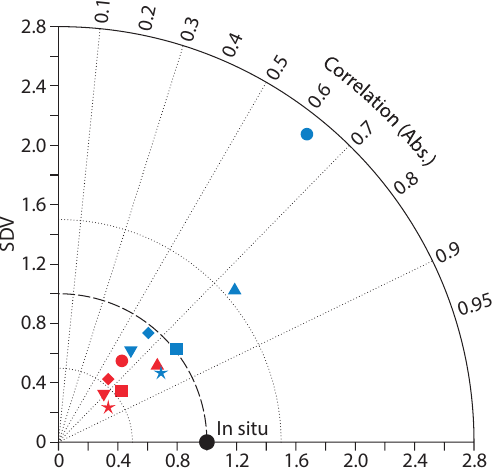
Figure 11. Taylor diagram illustrating the statistics from the com- parison between ERA-Interim/Land (blue) and ERA-Interim (red), compared to situ observations for 2010. Each symbol indicates the correlation value (angle), the normalized SD (radial distance to the origin point), and the normalized centred root mean square error (distance to the point marked “in situ”). Circles are for the stations of the AMMA network (3 stations), square for the OZNET network (36 stations), stars for the SMOSMANIA network (12 stations), tri- angles for the REMEDHUS network (17 stations), diamonds for the SCAN network (119 stations) and inverted triangle for the SNO- TEL network (193 stations). Only stations with significant correla- tion values are